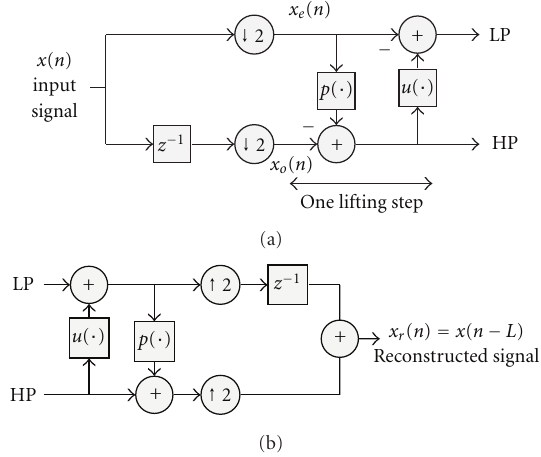
Figure 1: Wavelet transform realization via lifting scheme (a) Forward transformation. (b) Inverse transformation. The boxes labeled by z − 1 stand for delays (over one sample). The boxes ↓ 2 and ↑ 2 represent downsampling and upsampling by a factor of two, respectively; in the latter a zero is inserted after every sample, whereas in the former, every second sample is removed. The lifting scheme repeats two primitive steps: prediction p and update u